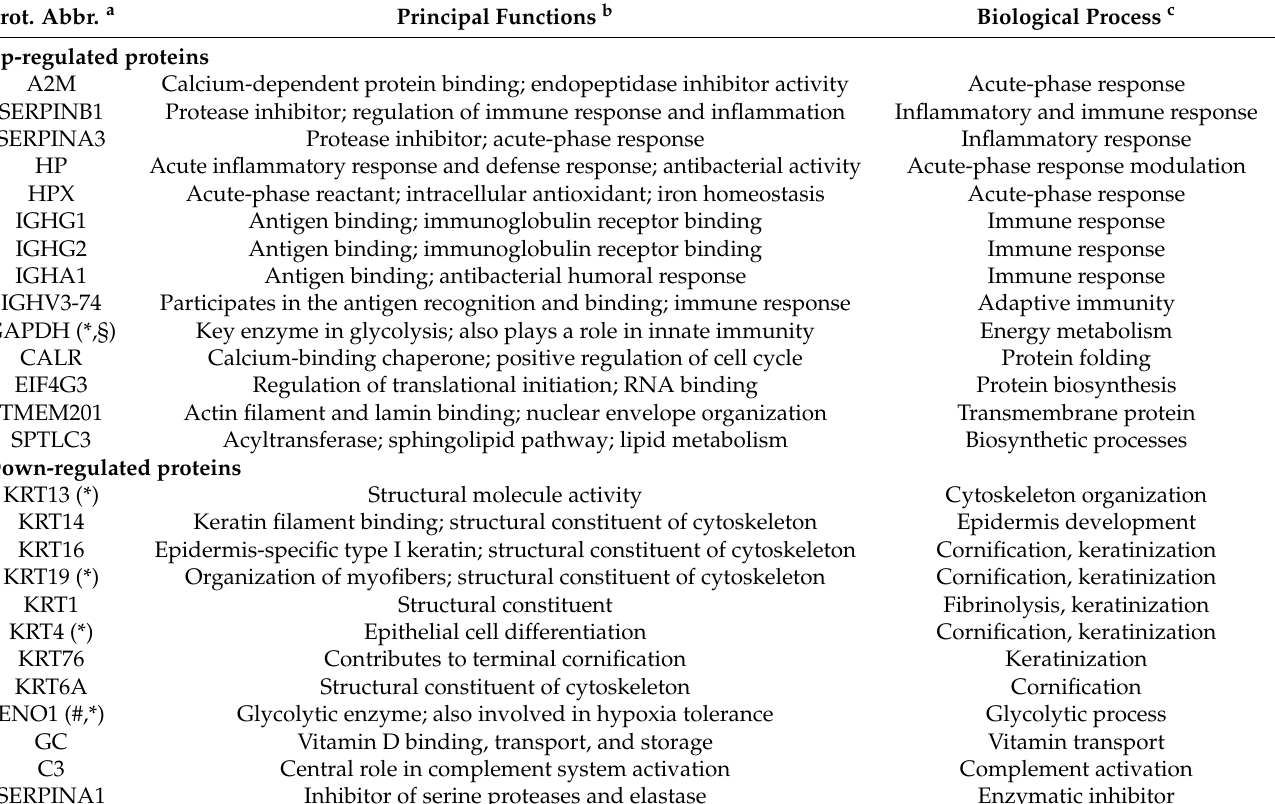
Table 2. The main roles of the differentially expressed proteins in D-GCF with respect to H-GCF. Prot. Abbr.